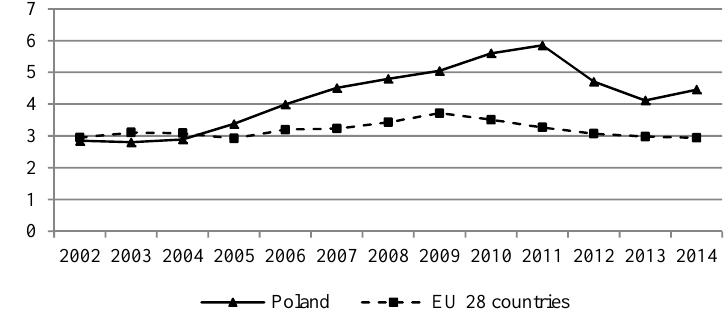
Figure 1. Gross fixed capital formation by government sector in Poland and EU 28 countries in the years 2002–2014 (as a percentage of